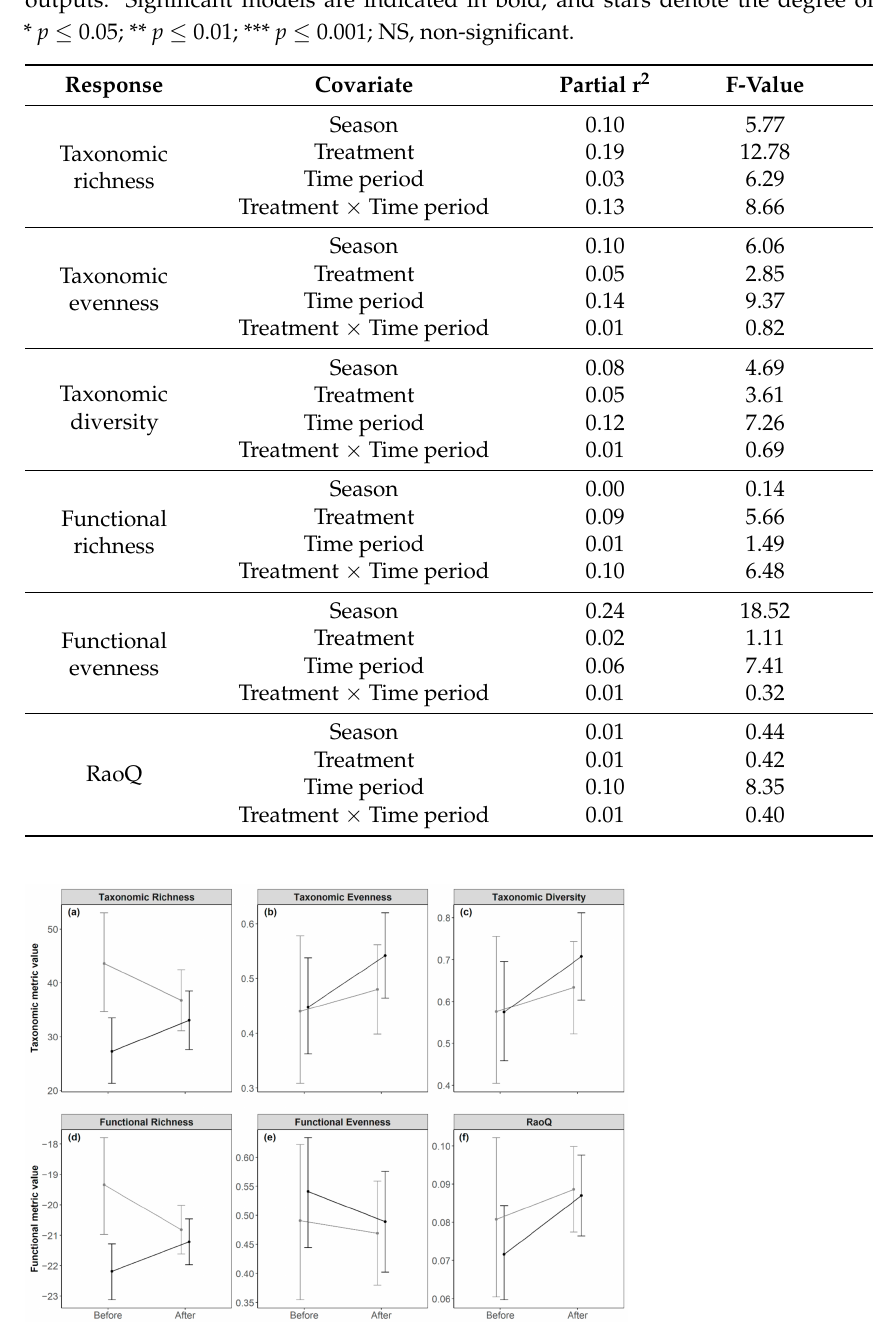
Table 4. Macroinvertebrate α -diversity responses to river restoration indicated by linear model outputs. Significant models are indicated in bold, and stars denote the degree of significance: